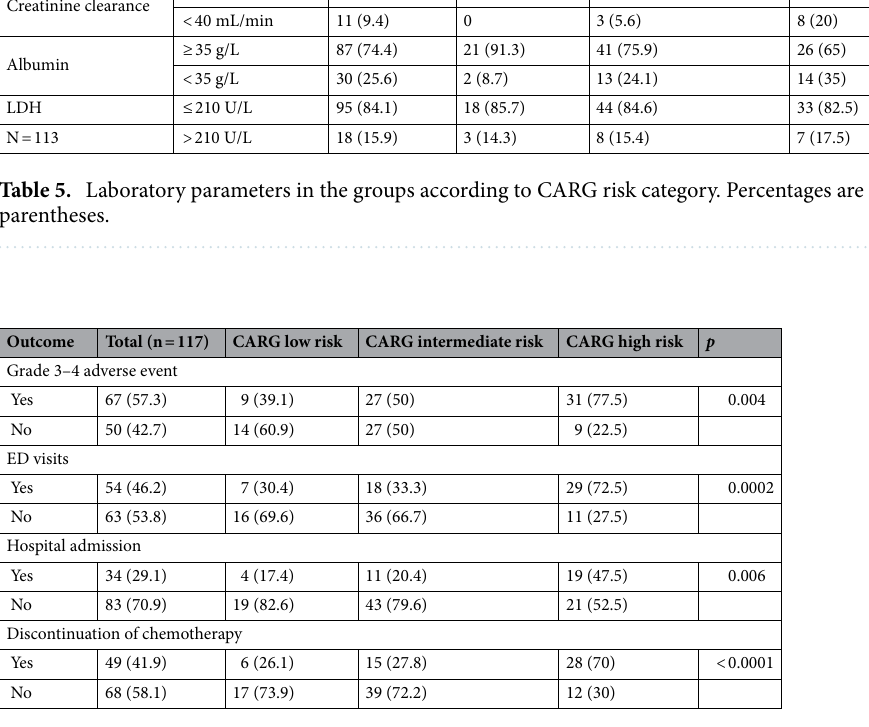
Table 6. Outcomes according to CARG risk category. Percentages are in parentheses. ED Emergency